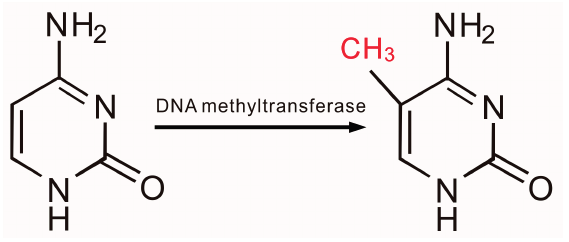
Figure 1. The process of DNA methylation.